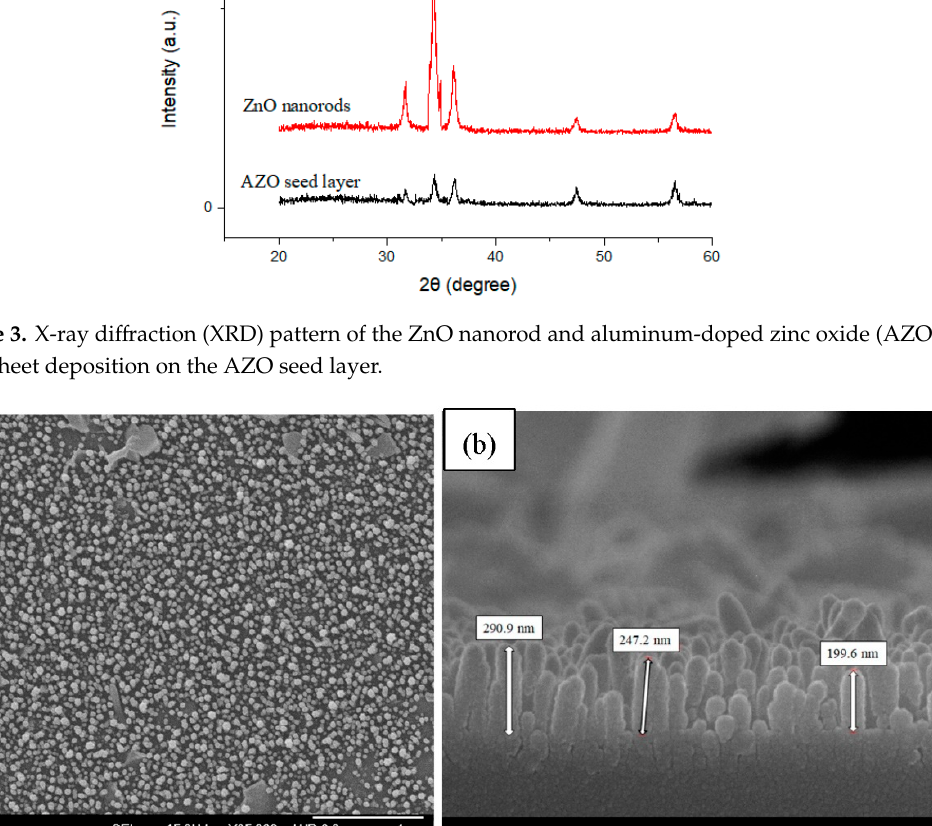
Figure 4. Field-Emission Scanning Electron Microscope (FE-SEM) images of ZnO nanorods. ( a ) top view and ( b ) cross section.